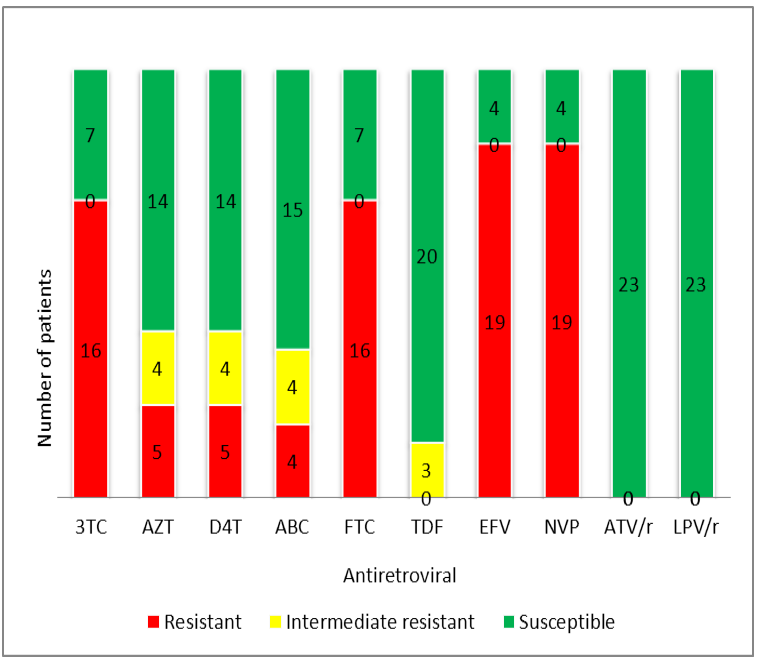
Figure 4. Proportion of drug resistance to antiretrovirals among successfully genotyped patients failing their first-line regimen in Tanzania. Genotypic interpretation according to Rega algorithms (v 8.0.1). 3TC = lamivudine, ABC = abacavir, AZT = zidovudine, D4T = stavudine, FTC = emtricitabine, TDF = tenofovir disoproxil fumarate, EFV = efavirenz, NVP = nevirapine, ATV/r = boosted atazanavir, LPV/r = boosted lopinavir. Table 4. Genotypic susceptibility score. Genotypic susceptibility of the current regimen and expected second-line regimen in genotypes from cART-experienced